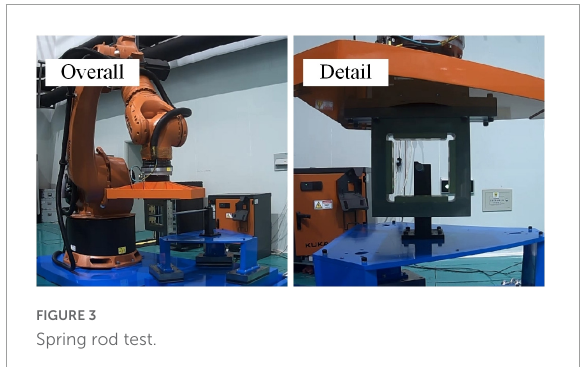
FIGURE3 Spring rod test.